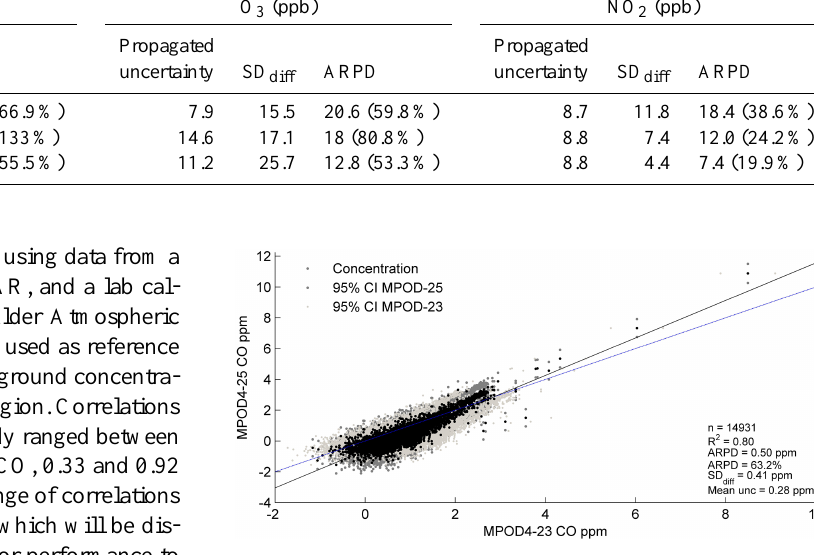
Figure 5. Personal CO measurement comparison between M-Pods 23 and 25, including 95% confidence intervals in light and dark gray,